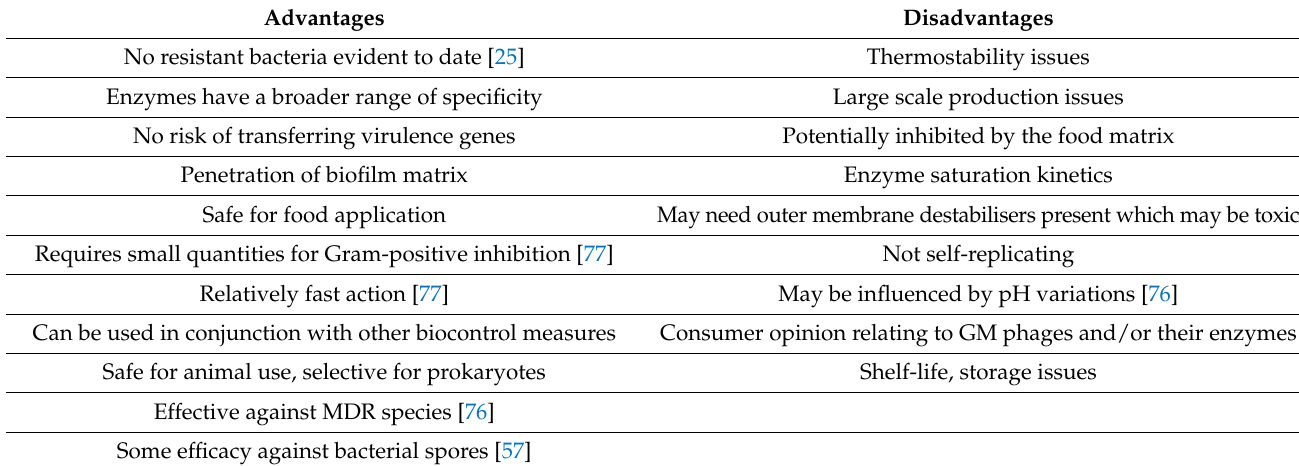
Table 3. Outlining the advantages and disadvantages of phage derived proteins as biocontrol